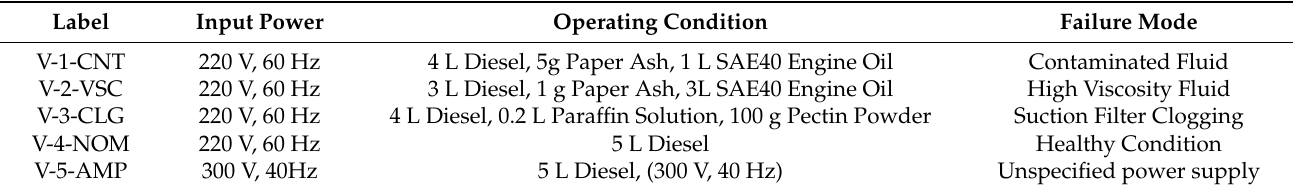
Table 2. Pump Running